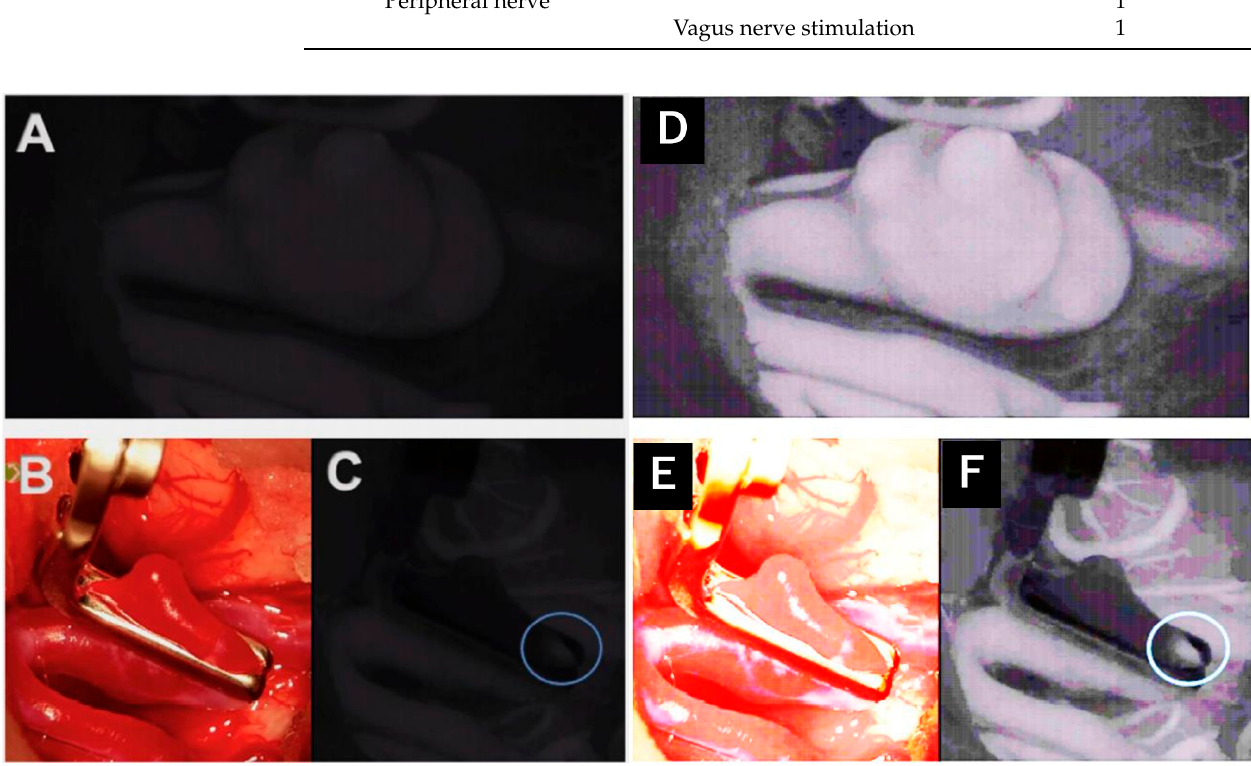
Figure 4. Intraoperative administration of indocyanine green during aneurysm clipping: Perception of indocyanine green during Aeos surgery in A and C. The unclipped aneurysm of the medial cerebral artery is dissected and visualized in ( A ). Visualization of the aneurysm under conventional light during surgery closed with a right-angled Sugita clip in ( B ). In ( C ) the light of the Aeos is on for post clipping control with indocyanine green. Rest perfusion in the clipped sack of the aneurysm at the right angle is highlighted with indocyanine green. Figures ( D – F ) show even enhanced contrast by image processing, which however intraoperativly is not necessary due to high definition backlighted LED screen.